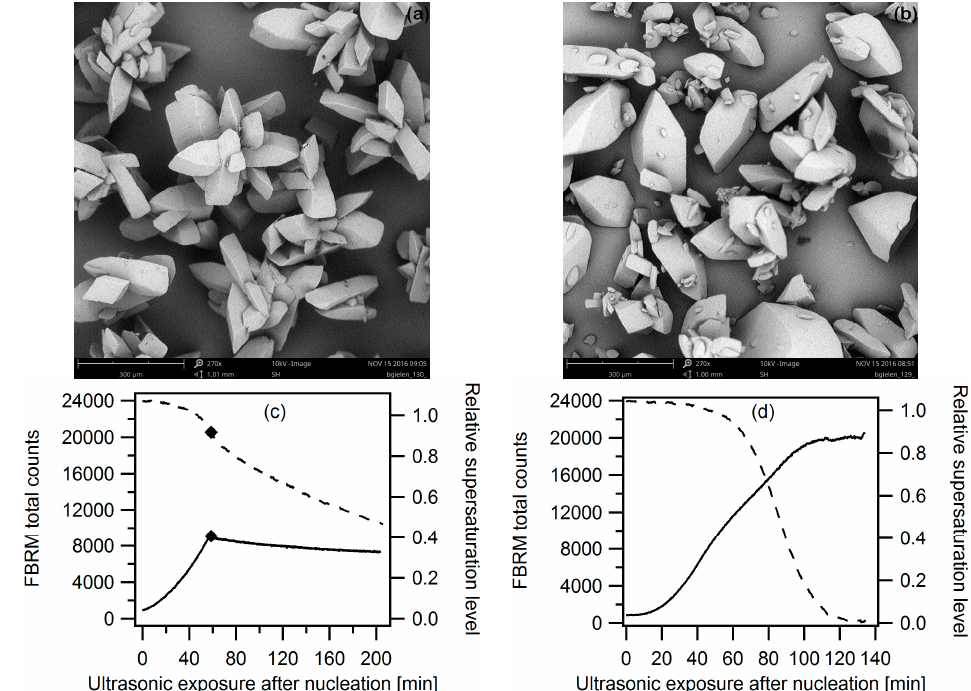
Figure 16 . FBRM, IR and SEM analysis of the crystal morphology obtained after a targeted application of ultrasound during the seeding stage at 70 °C, corresponding to C 0 / C sat = 1.77. The solid lines represent the FBRM data and the dashed lines show the relative supersaturation level. A comparison is made between: ( a , c ) limited exposure time which yields star-shaped crystals; and ( b , d ) the production of mono-crystals after sonication until complete desupersaturation.